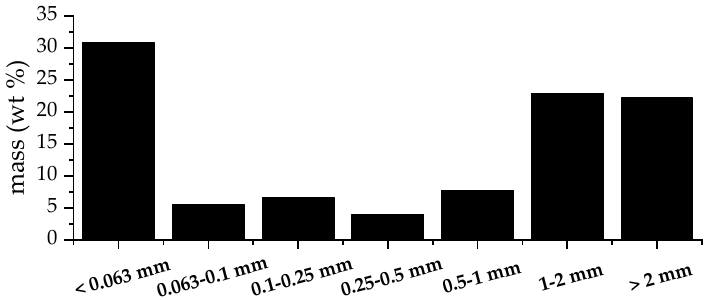
Figure 2. Particle size distribution.